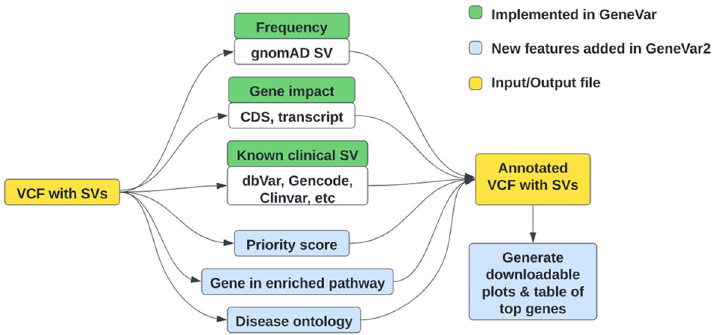
Figure 4. High-level outline of GeneVar2 workflow. Green boxes represent the initial features of GeneVar, implemented last year, while blue boxes represent new features implemented in GeneVar2 during this hackathon. (VCF: variant call format, SV: structural variation, CDS: coding